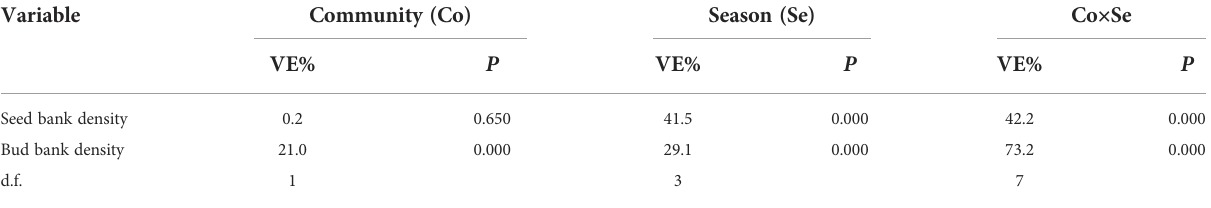
TABLE 1 Linear mixed model analysis of seed and bud bank densities among different sampling seasons and community types.